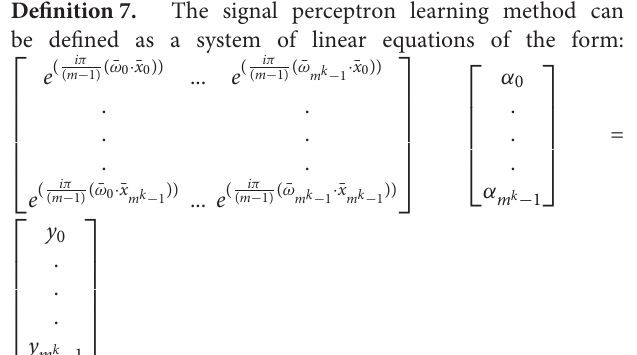
size | m k | = m k . This number is the upper-bound of the